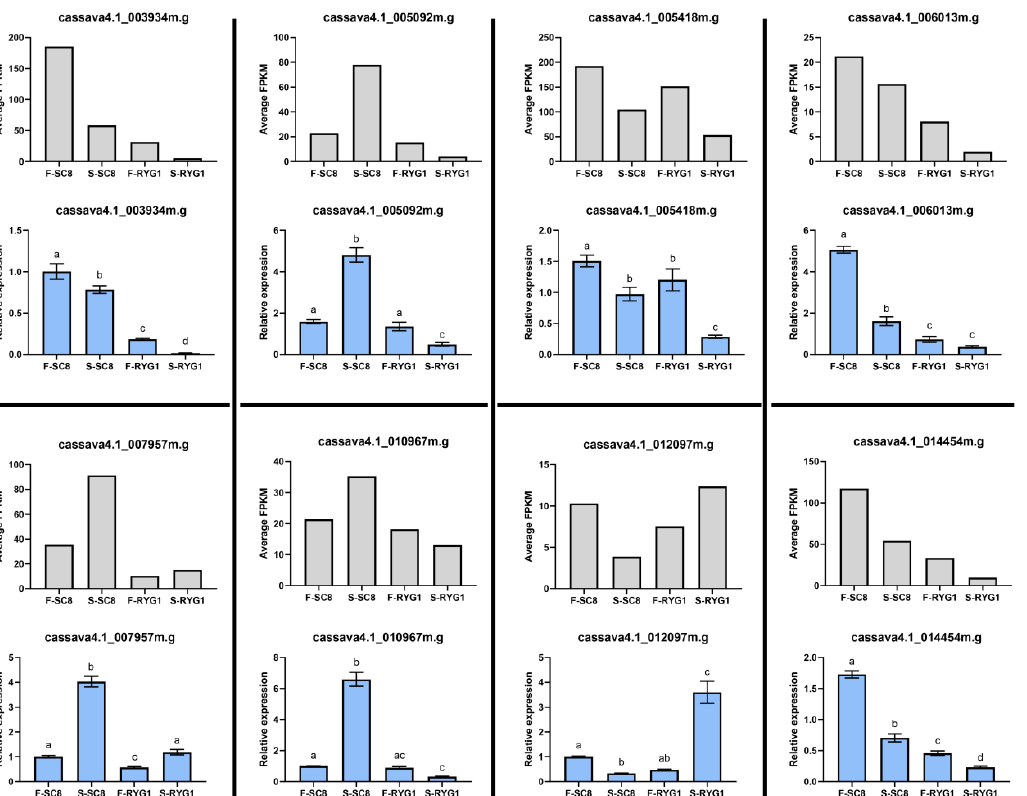
Figure 5. qRT-PCR validation of the RNA sequencing results for selected DEGs. The grey bars represent the FPKM values of genes from RNA-seq. The blue bars represent the values determined by qRT-PCR. The error bars indicate the standard deviation. The characters on the top of each bar indicate a significant difference.